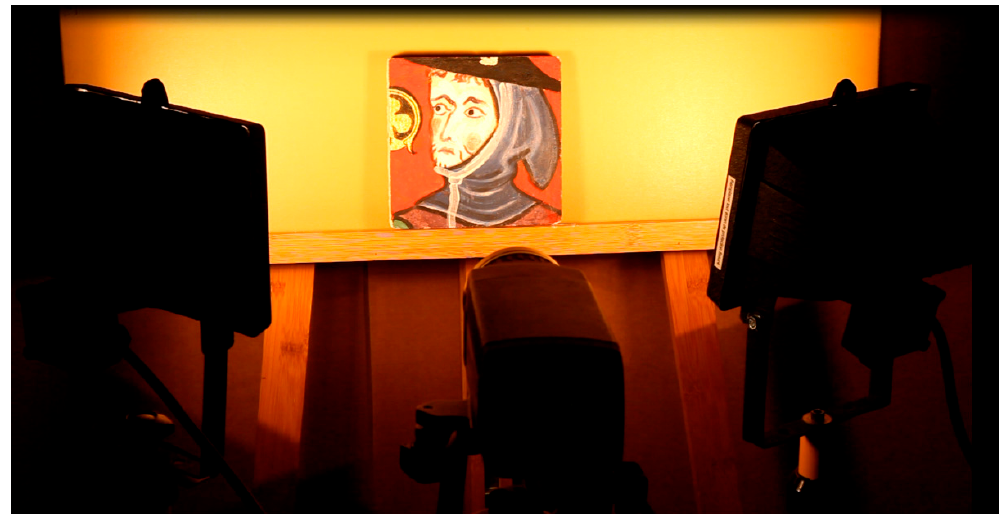
Figure 13. The copy of the mural painting" Saint Maurille en Evèque" under analysis.